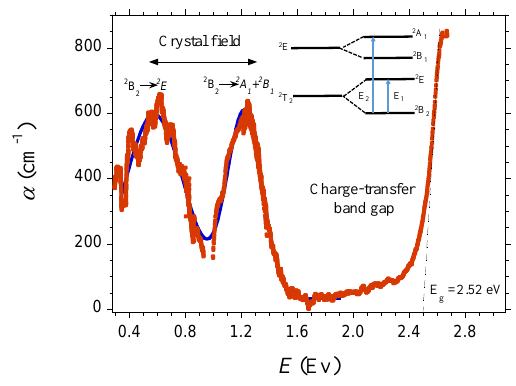
Figure 1: Optical absorption spectrum of Cs 2 CuCl 4 at ambient conditions. The blue line represents the fit of the experimental points to the sum of two Gaussian profiles. The crystal-field bands correspond to crystal- field d-d transitions: 2 B 2 → 2 E (0.55 eV) and 2 B 2 → 2 A 1 (1.30 eV) in D 2 d symmetry. The high-energy ab- sorption threshold corresponds to the Cl − → Cu 2+ CT band gap, which is E g = 2.52